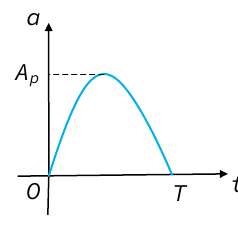
Figure 2. Shock load.